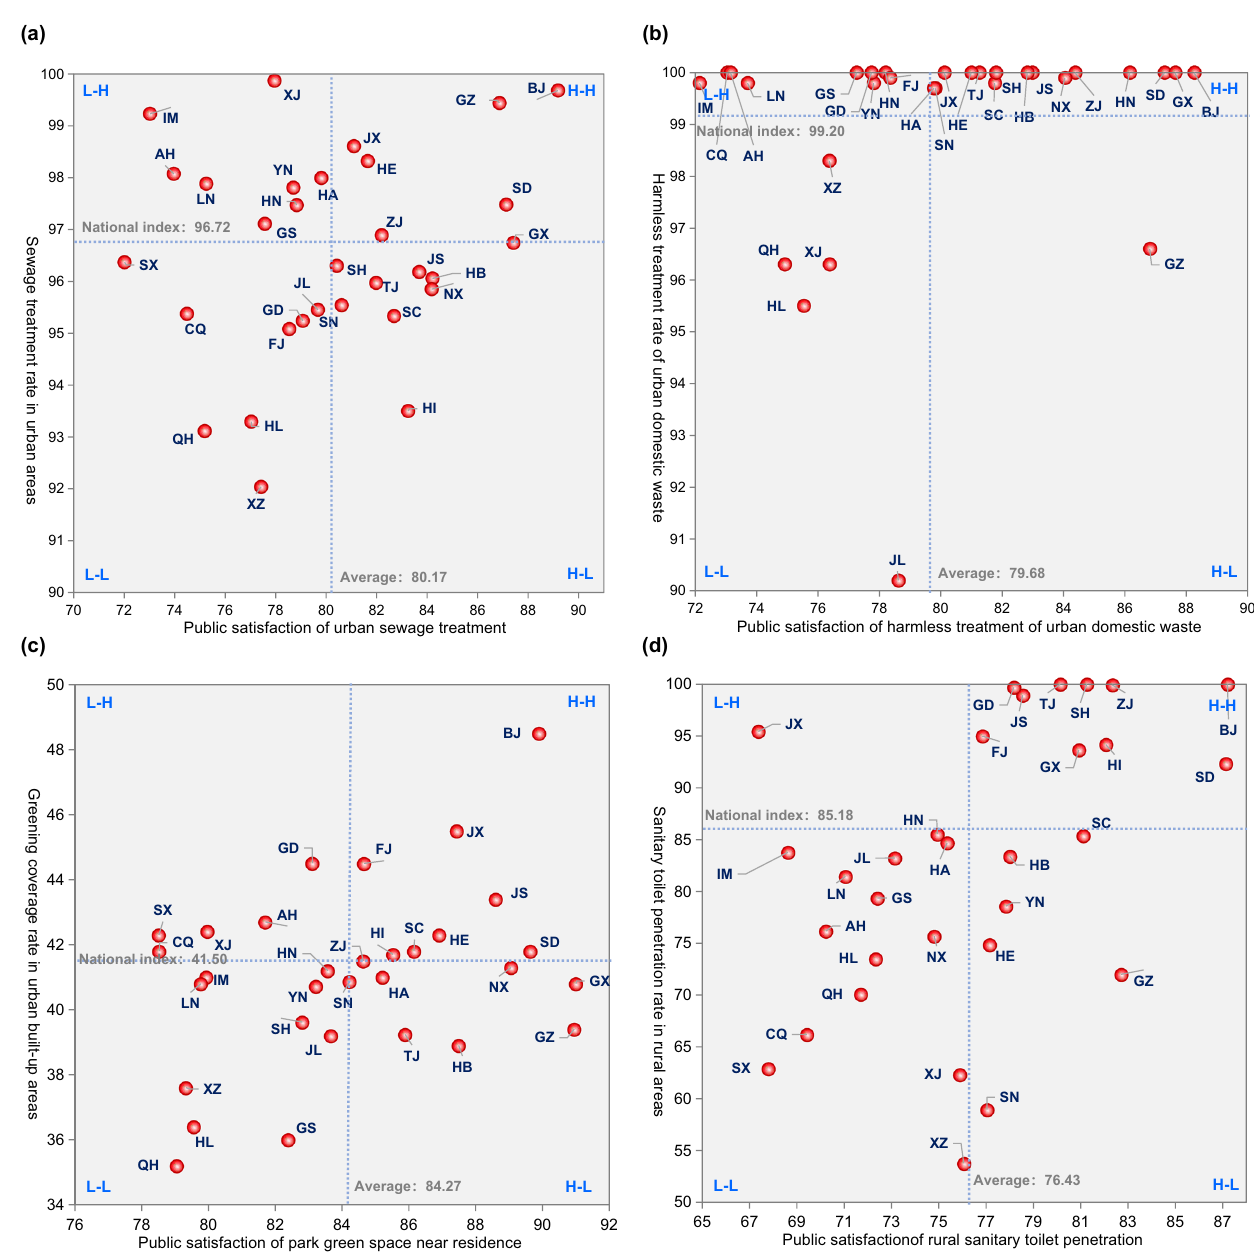
Fig. 8 Type of relationship between quality evaluation and public satisfaction of each indicator of human settlements. a – e Displayed the four indicators. a Urban sewage treatment. b Harmless treatment of urban domestic waste. c Urban greening coverage. d Rural sanitary toilet